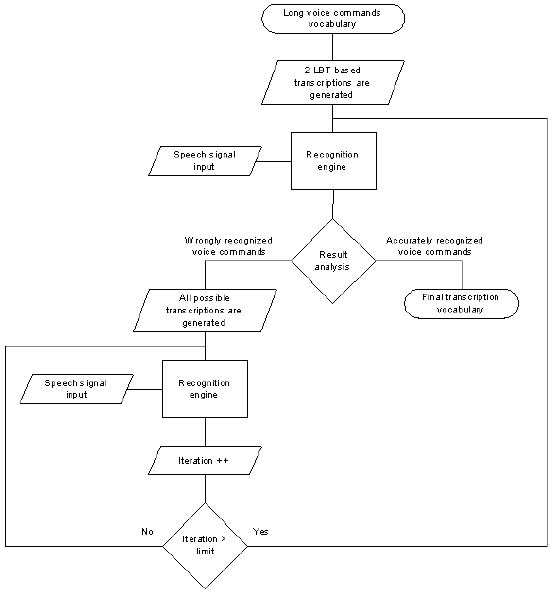
Figure 1. The algorithm for long voice command transcription cre-